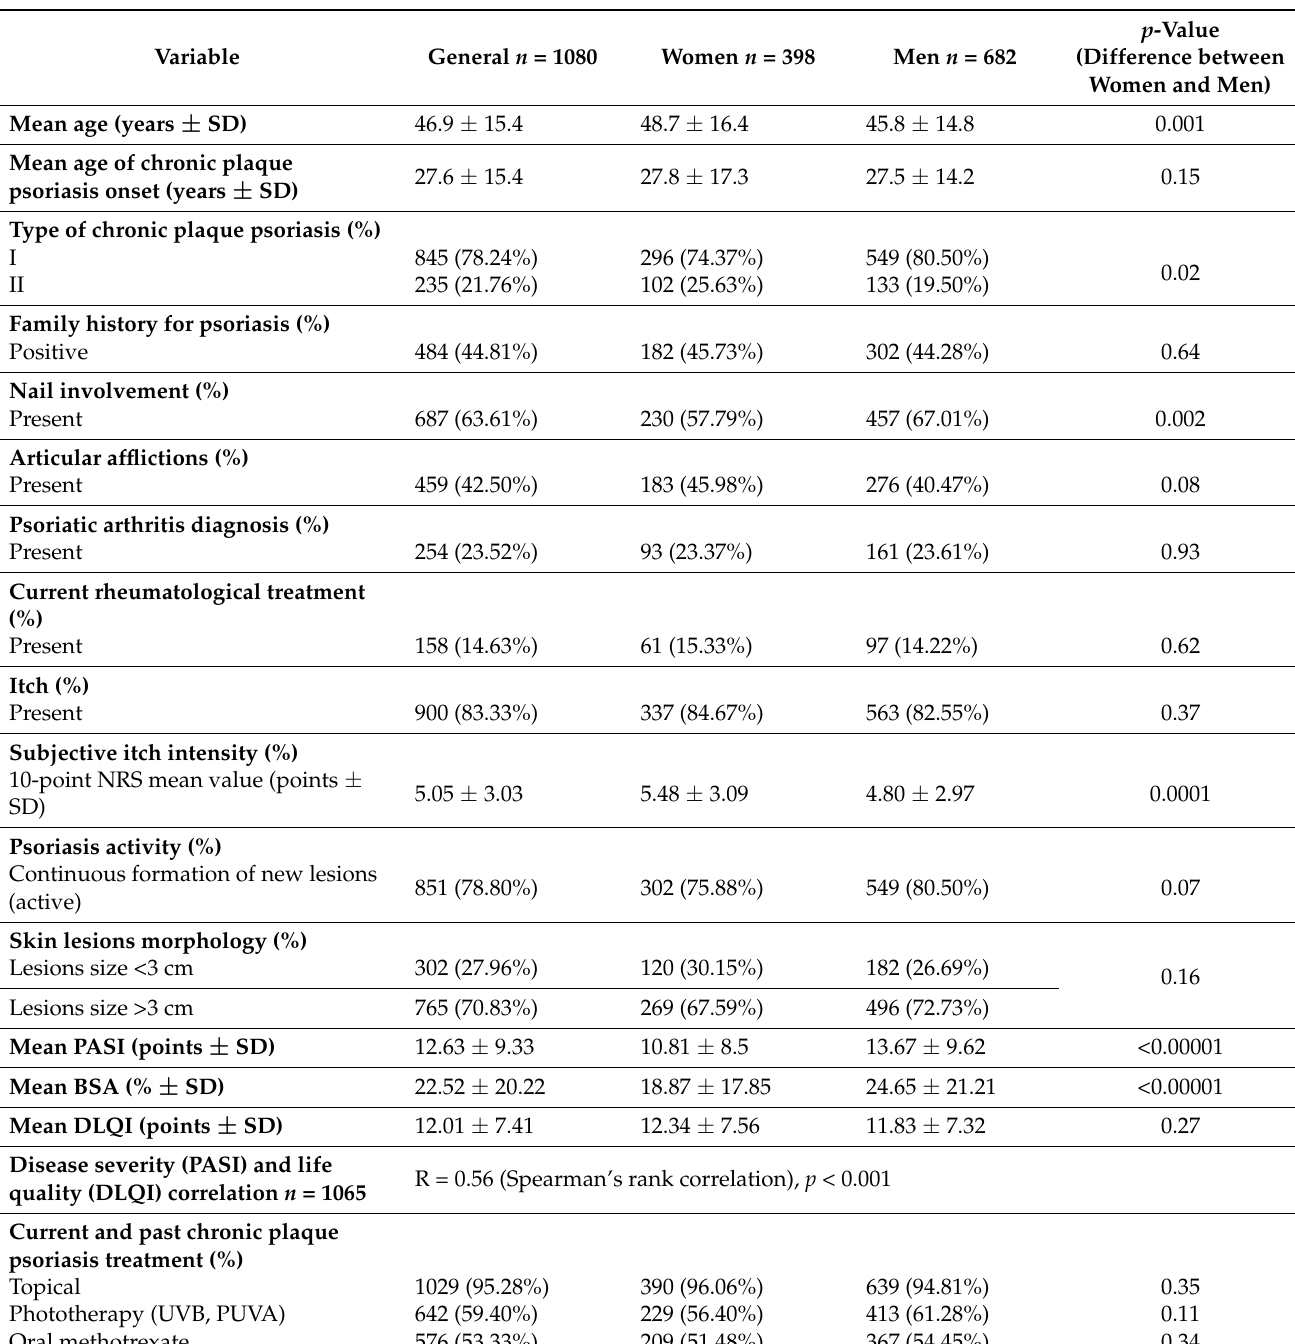
Table 1. Disease characteristics of the Polish chronic plaque psoriasis